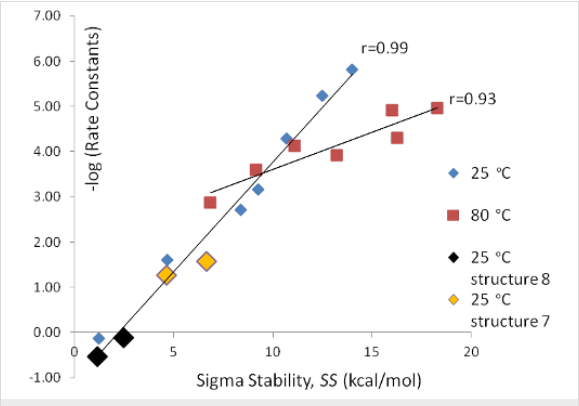
Figure 2: –log k as a function of SS in water for series A and B.